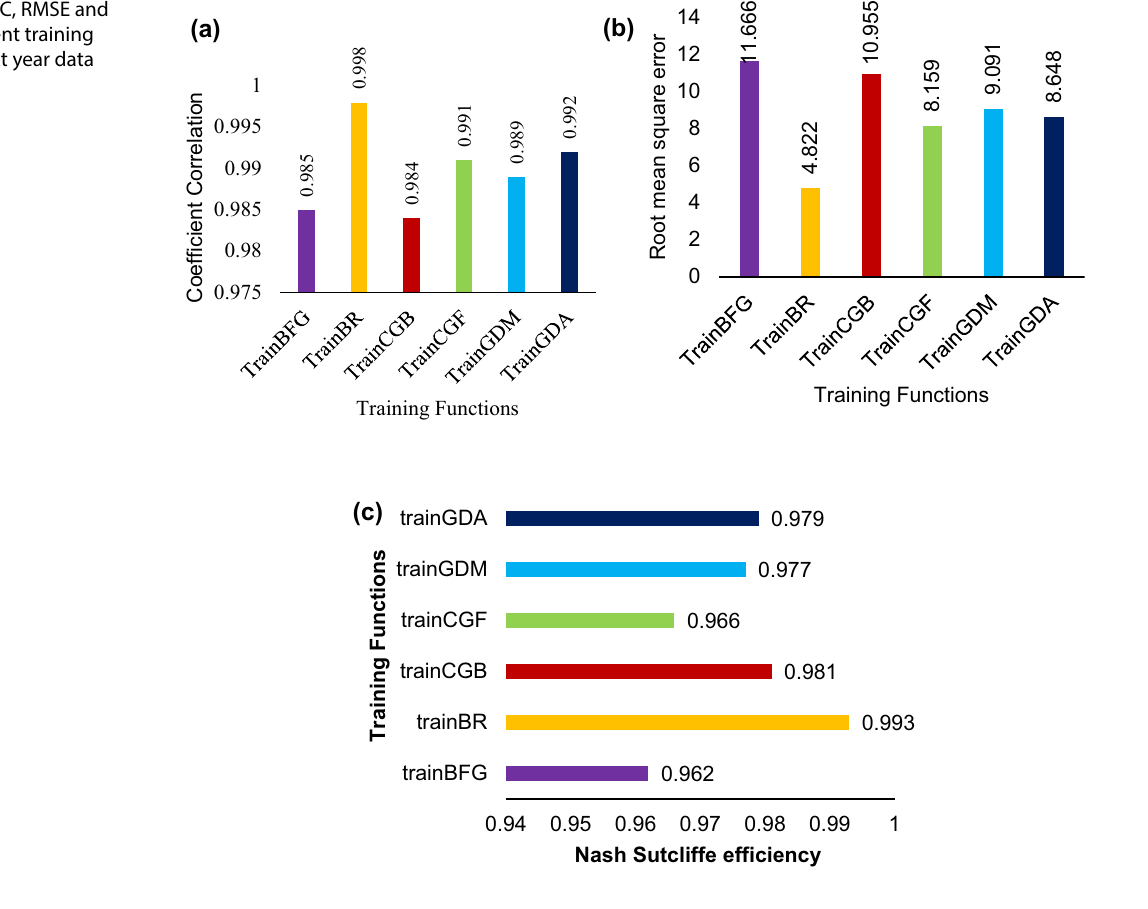
Fig. 10 Overall CC, RMSE and NSE using different training functions for next year data prediction